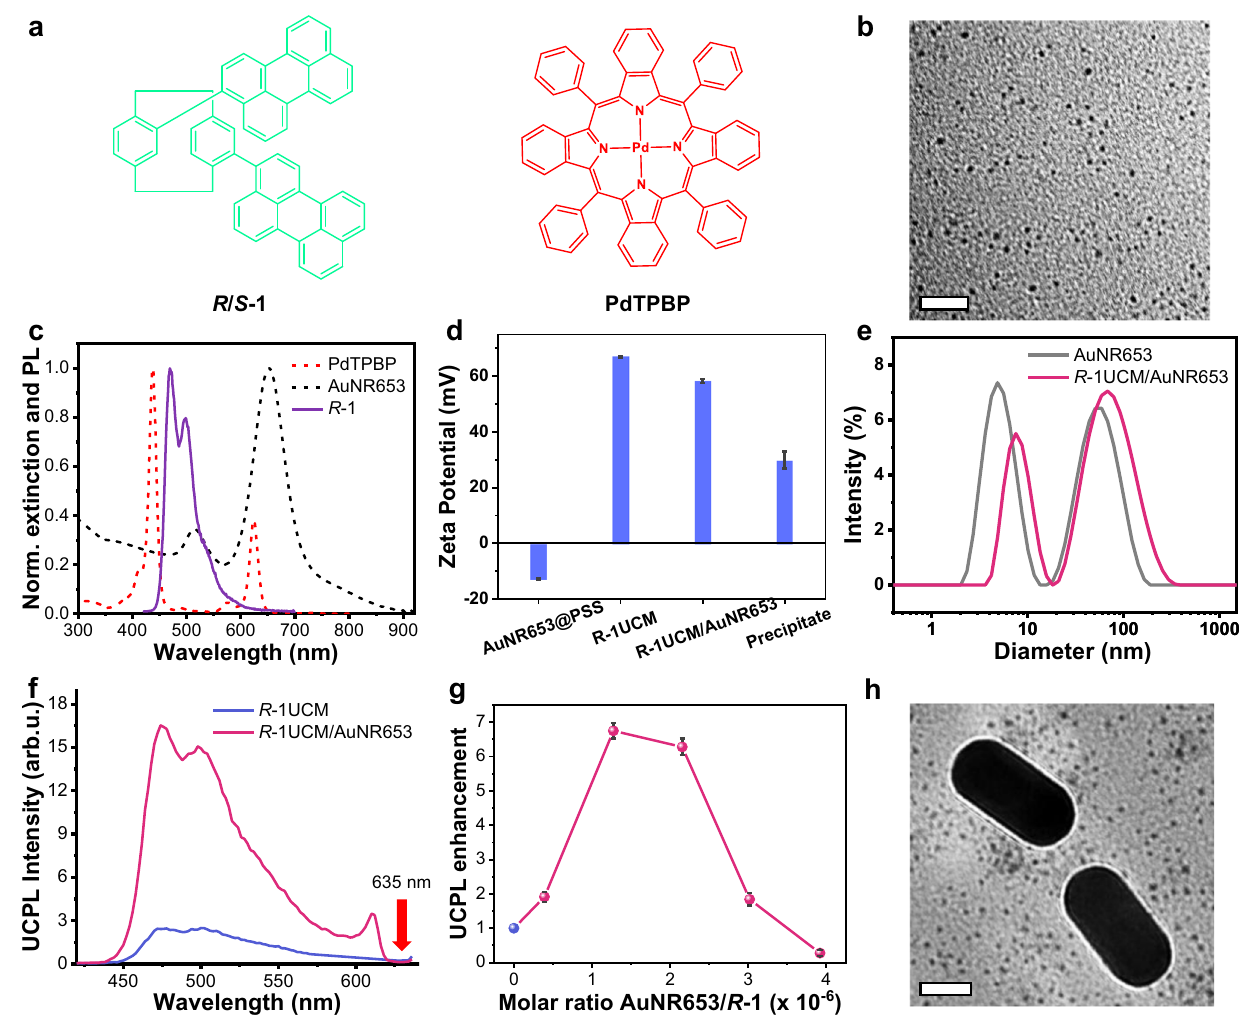
Fig. 2 | Photon upconversion of plasmon-micelle composites. a Molecular structuresofchiralemitters R / S − 1andsensitizerPdTPBP. b TEMimageof R − 1UCM. Scalebar=20nm. c Normalizedextinction(dashline)andphotoluminescence(PL, solid line) spectra of PdTPBP and R − 1 in THF and AuNR653 in water. λ ex =400nm. [ R -1]=[PdTPBP]=10 − 5 molL − 1 , [AuNR653]=10 -10 molL − 1 . d Zeta potential of R - 1UCM, R -1UCM/AuNR653 and AuNR653 in water. All error bars show mean± standarddeviation. n =3independentexperiments. e Particlesizedistributionfora stable dispersion of AuNR653 and R -1UCM/AuNR653 in water obtained by DLS. f Upconverted PL spectra of R -1UCM and R -1UCM/AuNR653 in deaerated water